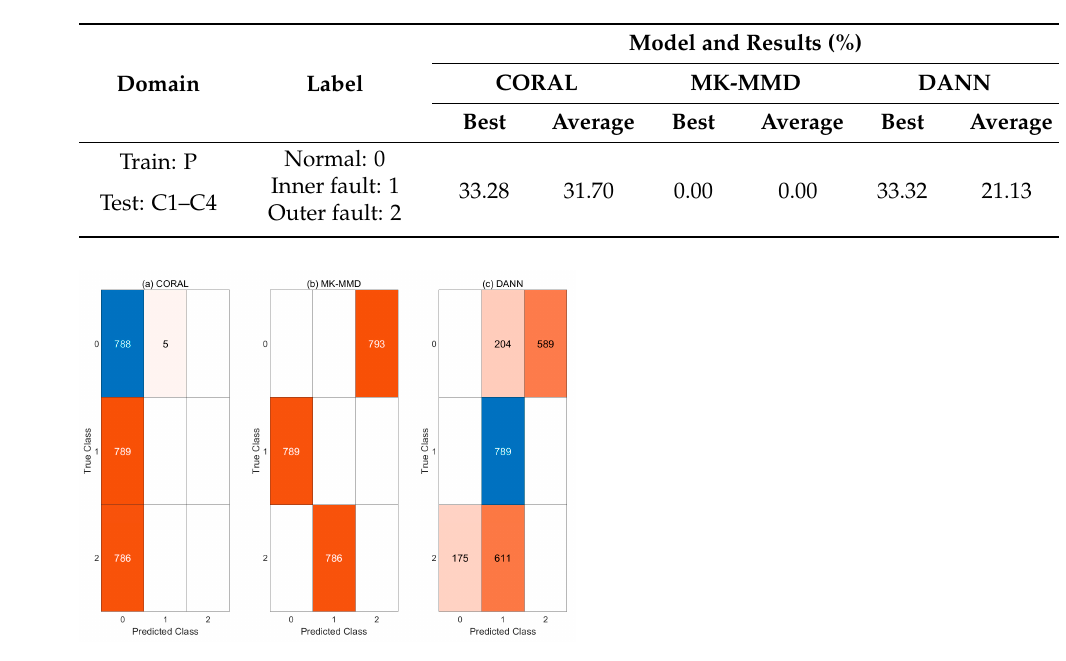
Figure 11. Confusion matrices of case 2: ( a ) CORAL ( b ) MK-MMD ( c ) DANN.